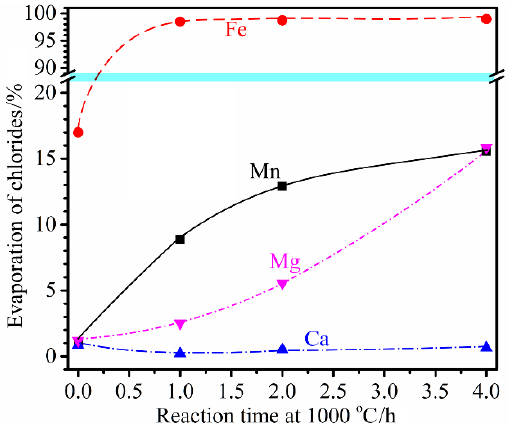
Figure 15. Evaporation degrees of metal chlorides vs. reaction time at 1000 °C with the addition of 20 wt% CaCl 2 and 40 wt% MgCl 2 .